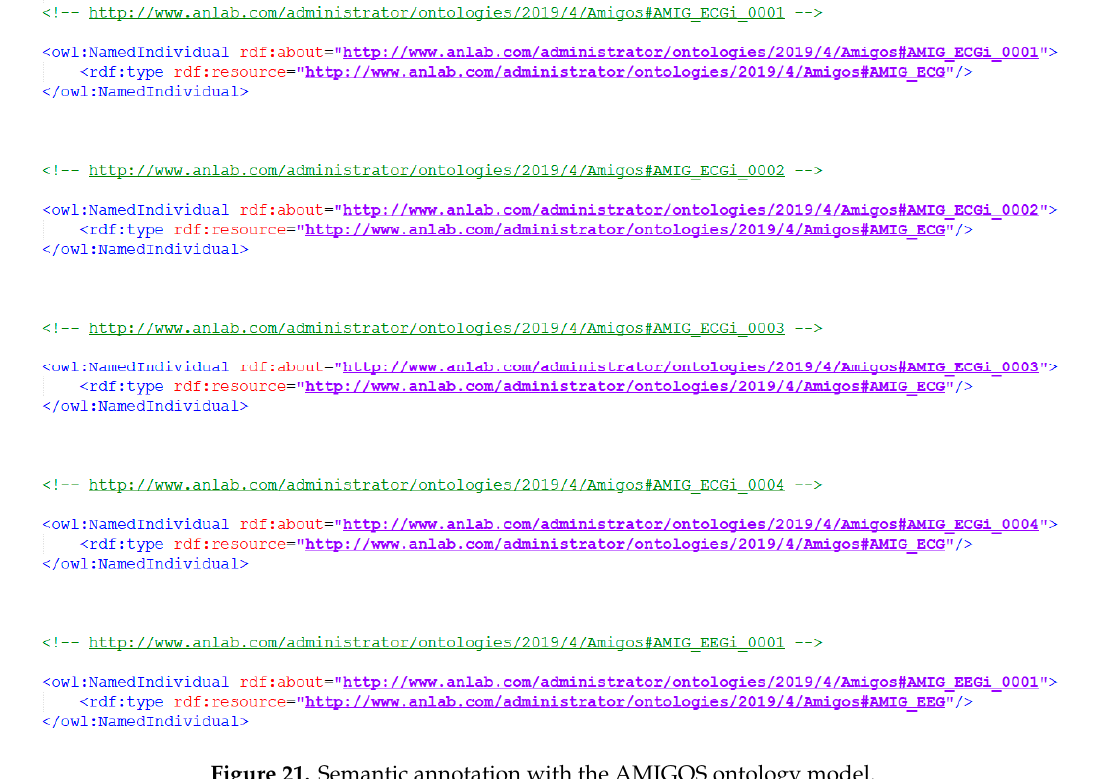
Figure 21. Semantic annotation with the AMIGOS ontology model.